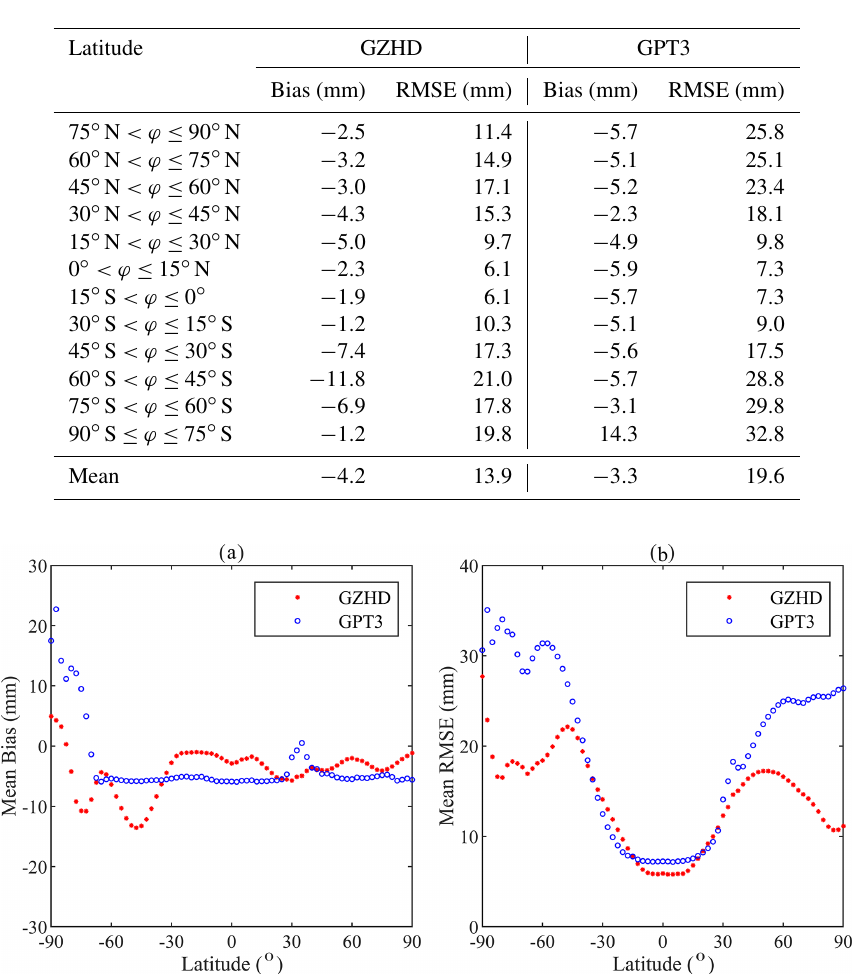
Table 2. Mean of the biases and RMSEs of ZHD-GZHD and ZHD-GPT3 during the 19-year period of 2000–2018 in different latitude ranges (with a 15 ◦ interval).